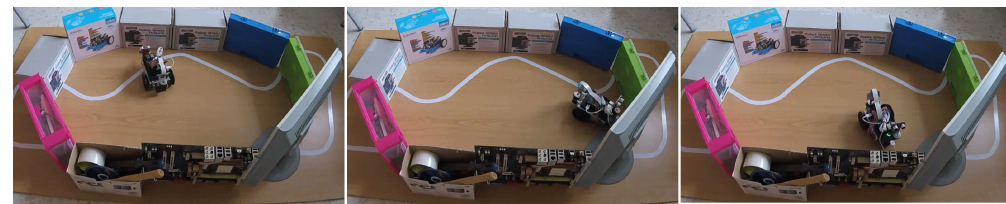
Figure 15. Navigation practice avoiding obstacles through US in PiBot .